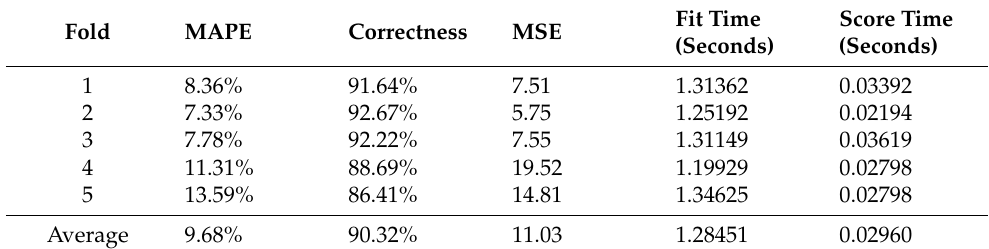
Table 6. The results of k-fold cross validation with RFR model training.